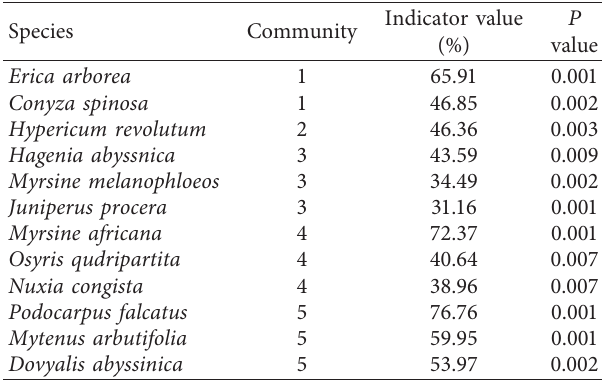
Table 2: Indicator species in each community with significant indicator values (%).